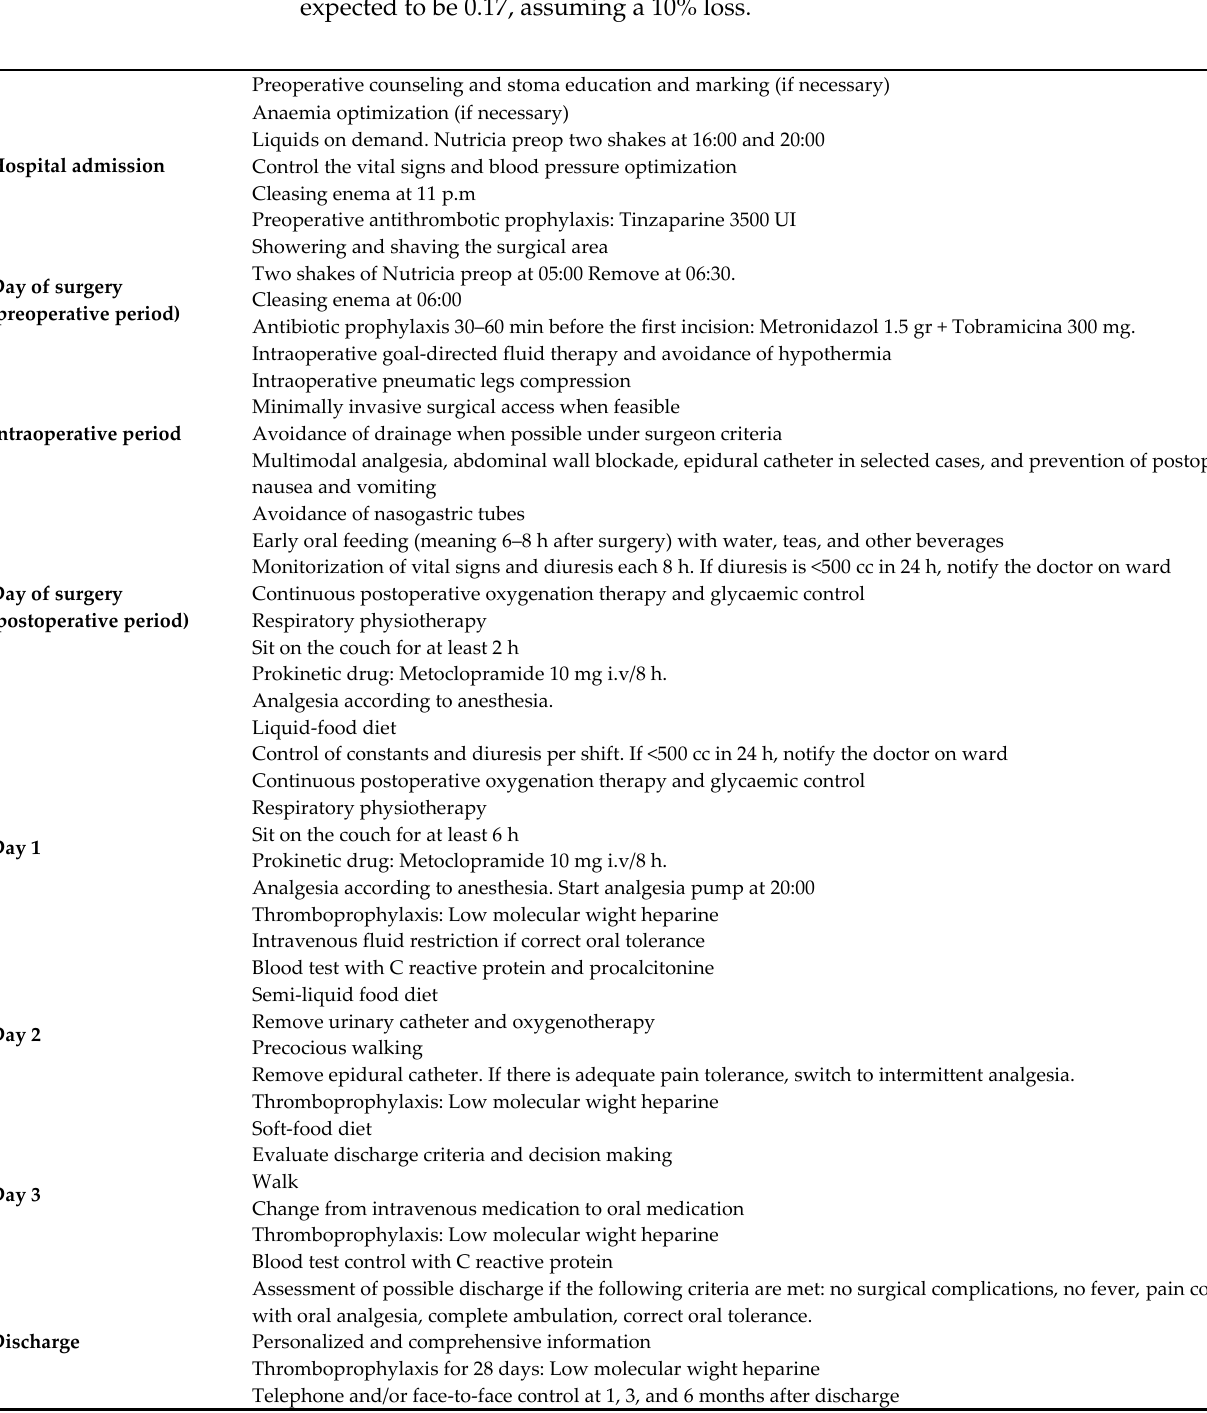
Figure 1. Enhanced recovery program.